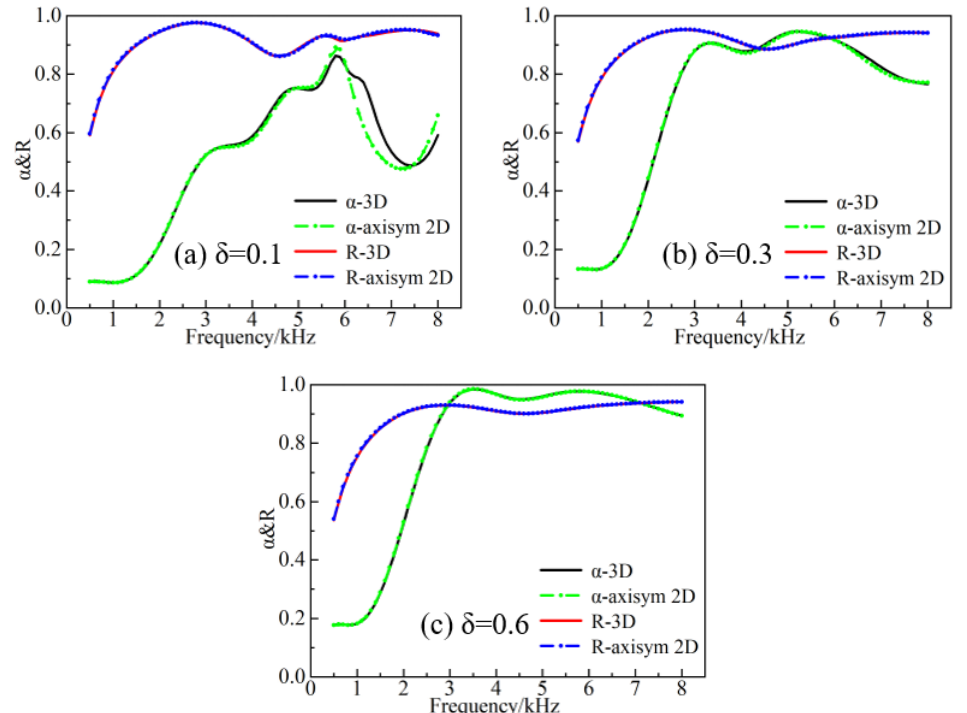
Figure 11. Forward absorption and backward reflection with different loss factors.